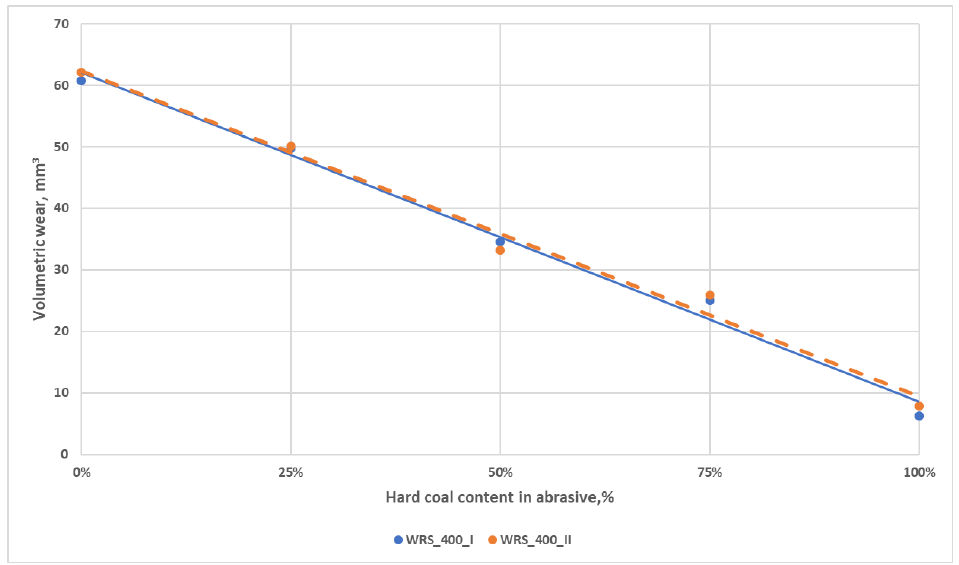
Figure 16. Final volumetric wear u V of WRS_400_I and WRS_400_II steels in a function of coal content in a coal-quartz abrasive; the diagram includes the result for quartz abrasive (0% of hard coal) and coal abrasive (100% of hard coal).